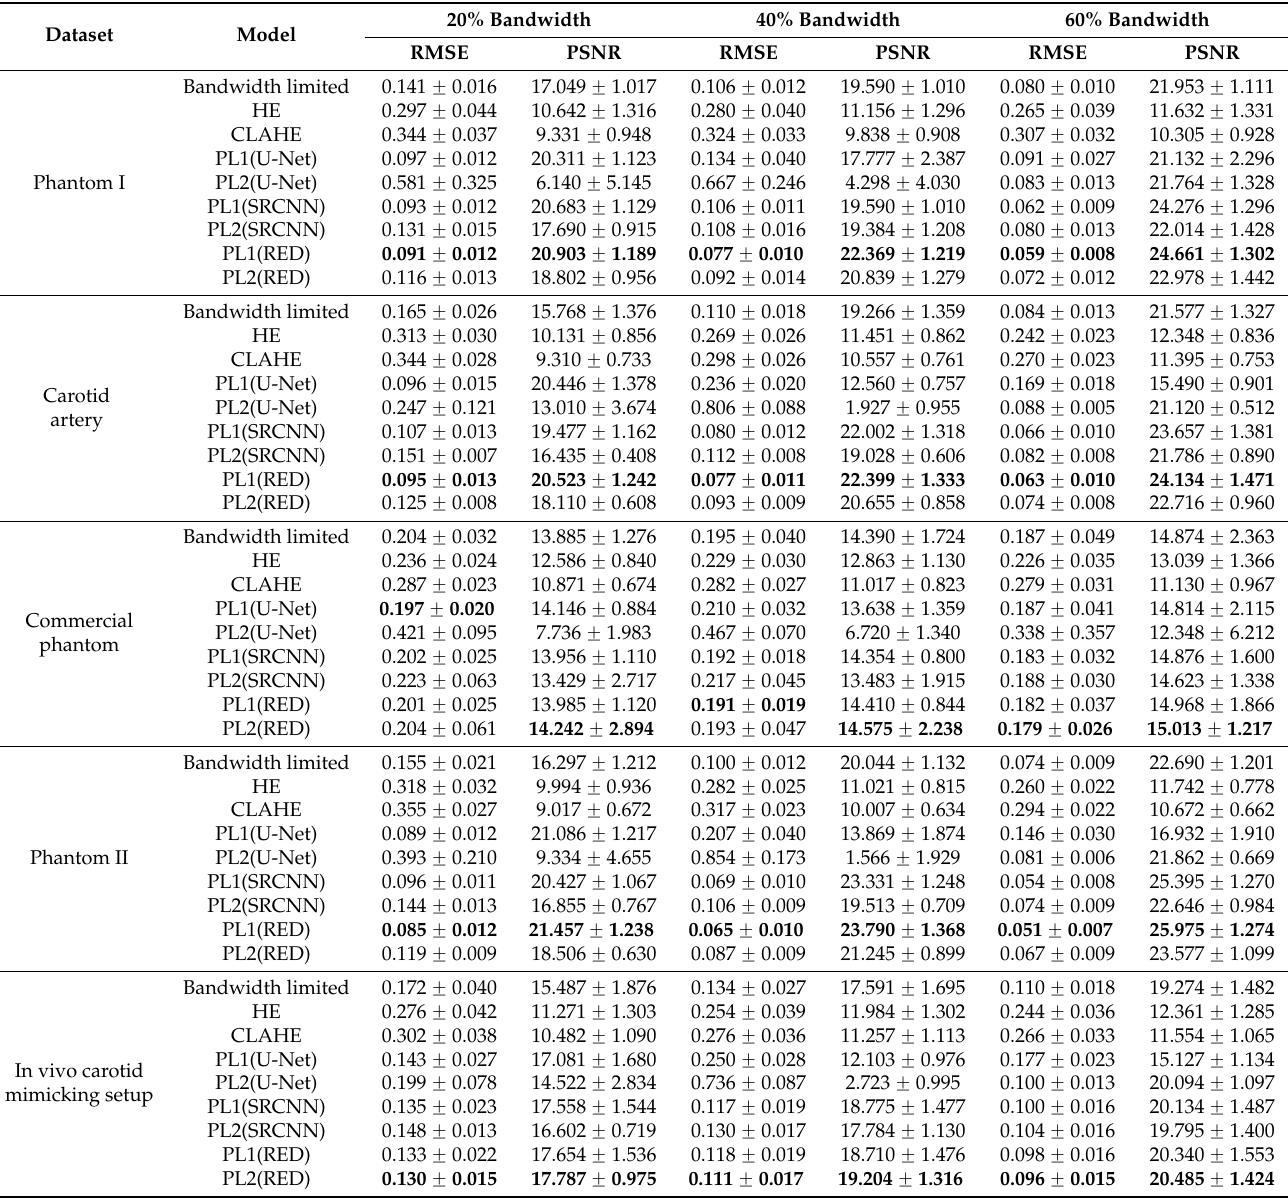
Table 2. The average metric values for all the test datasets, for all the models and state-of-the-art techniques for 20 % Bandwidth. The best scores for each dataset are written in bold